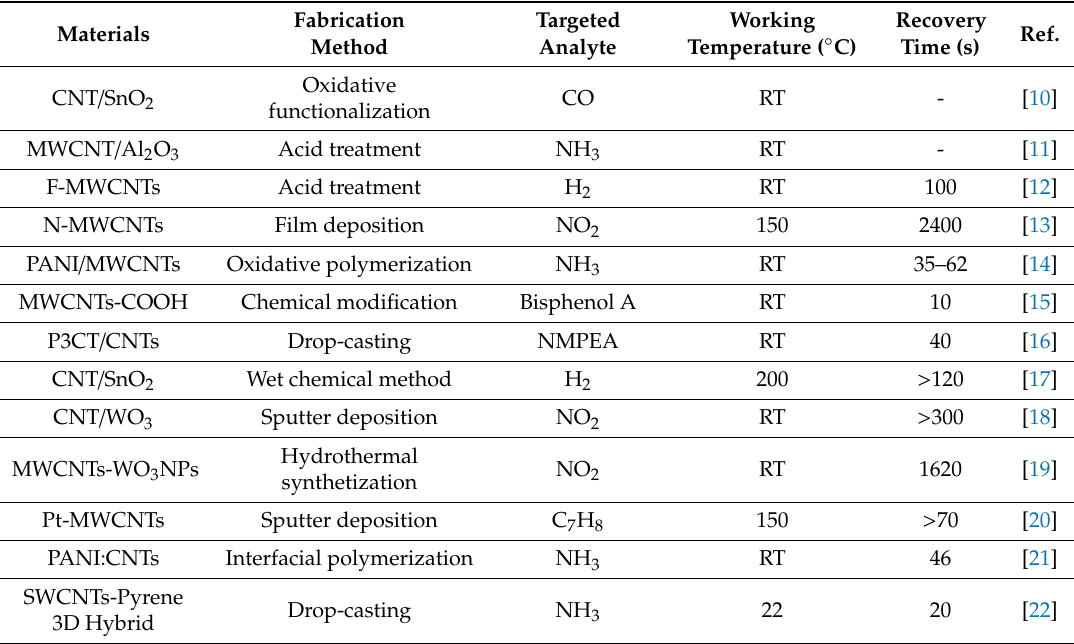
Table 1. Analytical performance comparison of previously reported works with carbon nanotubes (CNT) gas